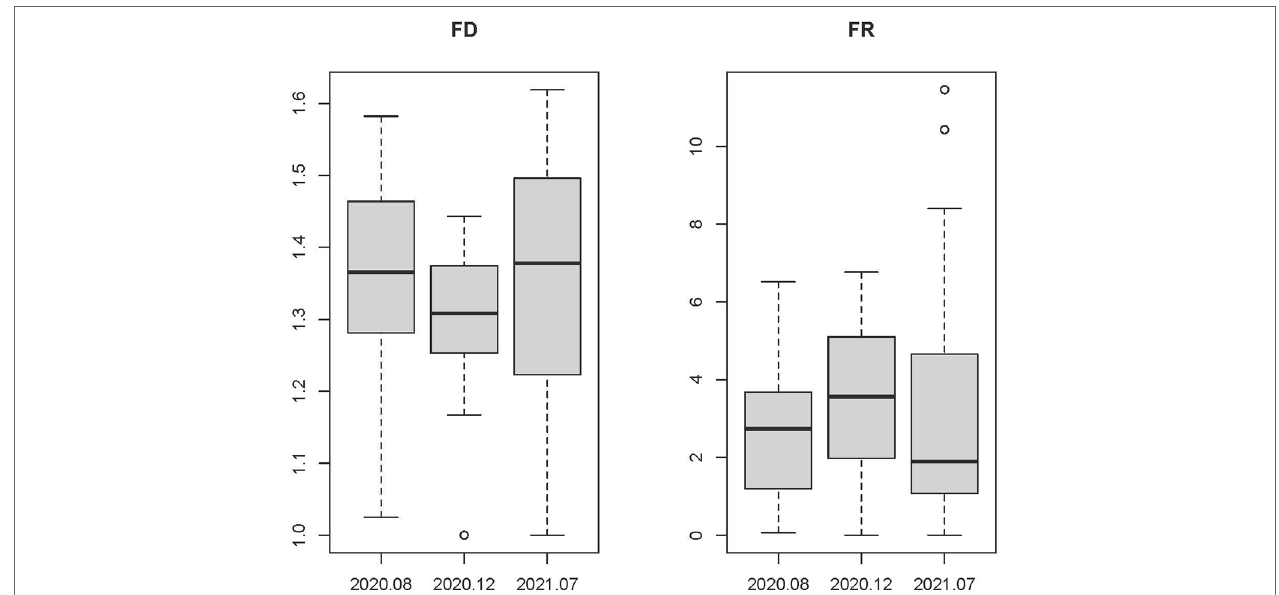
FIGURE 5 | Variations in the functional diversity (FD) and functional redundancy (FR) indices of the demersal fish communities in the